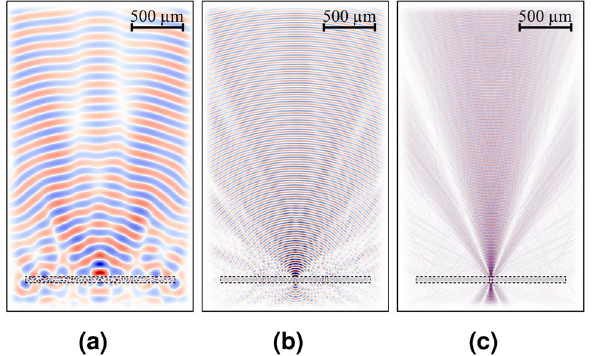
Figure 3. Meep FDTD simulations for ( a ) 300 GHz. ( b ) 1 THz. ( c ) 3 THz. The lens-antenna represented by a dashed